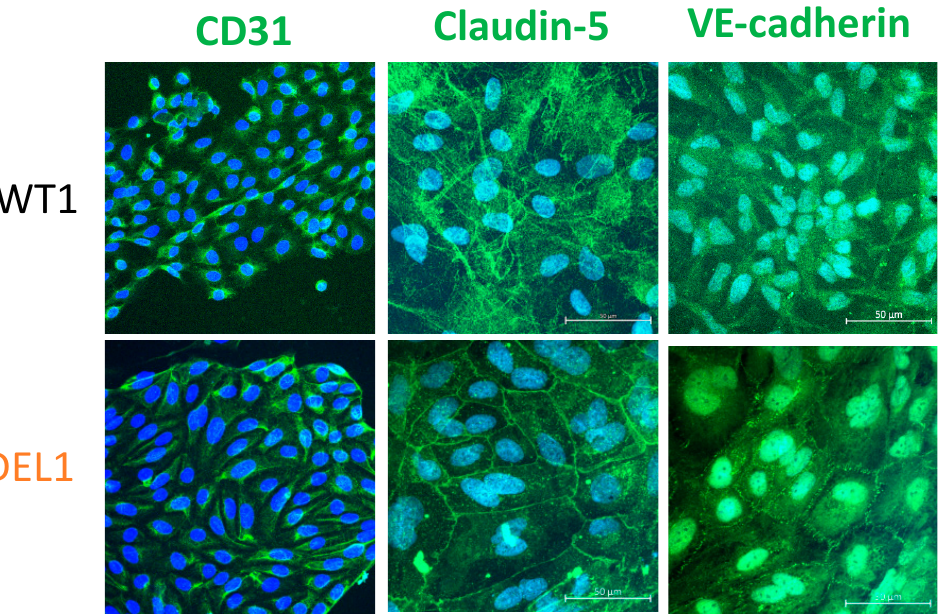
Figure A4. Confocal images showing CD 31, claudin-5, and VE-cadhesion at the HBMEC monolayer for the control (WT1) and 22q11.2DS-SCZ (DEL1) from one paired iPSC. The ones for CD 31 were cultured on the glass-bottom dishes, and those for claudin-5 and VE-cadherin were cultured on the Transwell Filters.